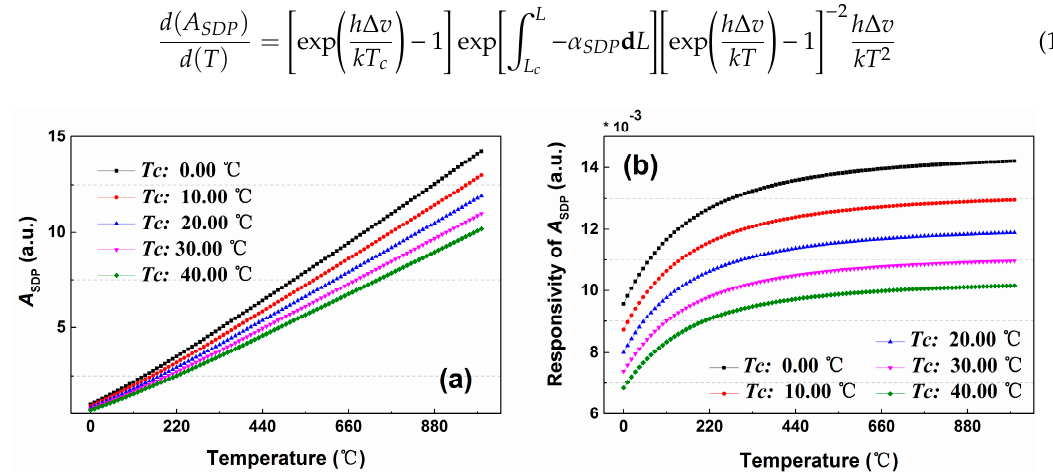
Figure 16. ( a ) The relationship of A SDP and the measurement temperature under the different calibration temperatures. ( b ) The responsivity of A DDP to the measurement temperature.